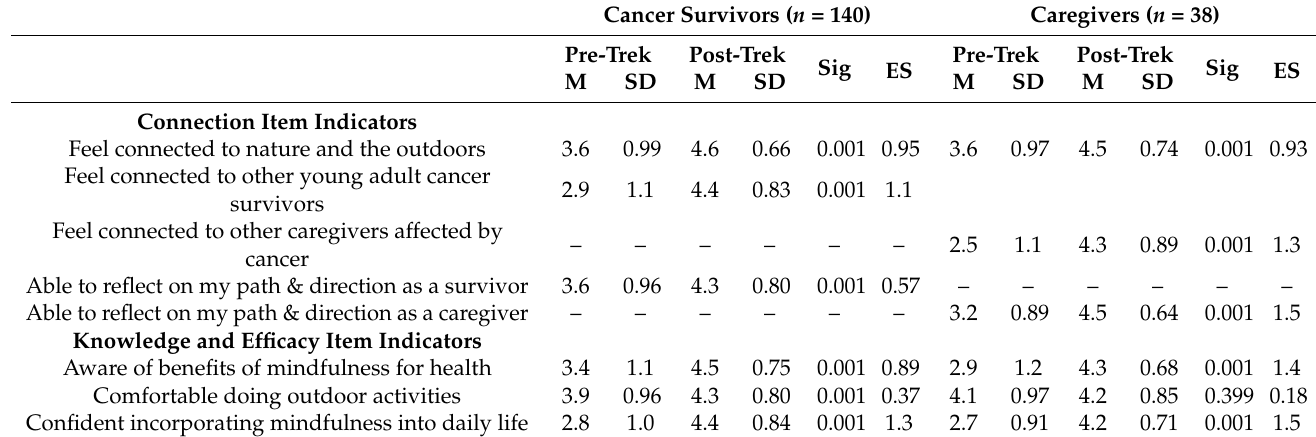
Table 2. Pre-Post Changes in Reflection, Connection, Knowledge, and Efficacy (2016–2021).